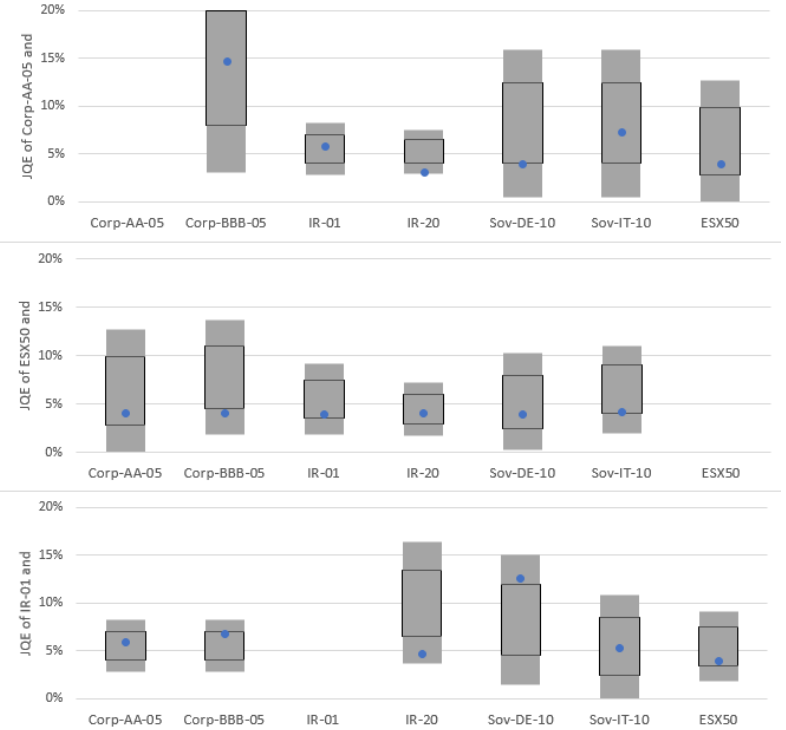
Figure 14. Comparison of the joint quantile exceedance for selected risk factors; representation based on own results (blue dots) and EIOPA (2021a, p. 35) (gray